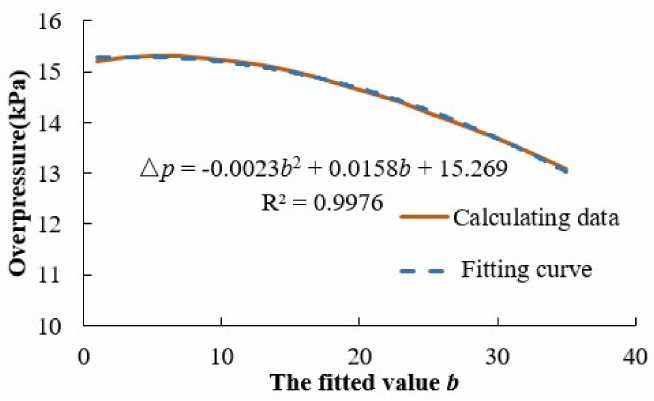
Figure 12. The relationship between shock wave overpressures and fitted value b (which is relevant to the gas desorption